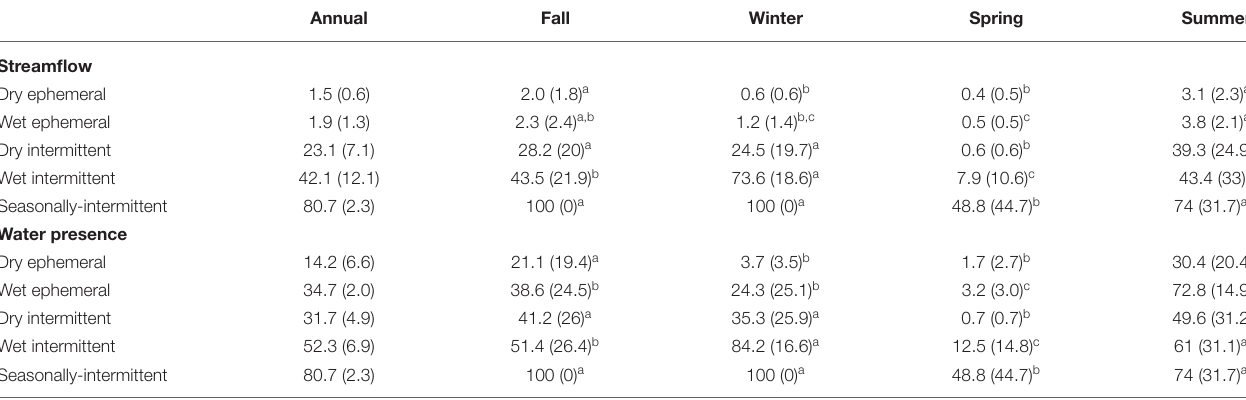
TABLE 3 | Mean (SD) values of annual % streamflow and % water presence and monthly % streamflow and % water presence for each season.